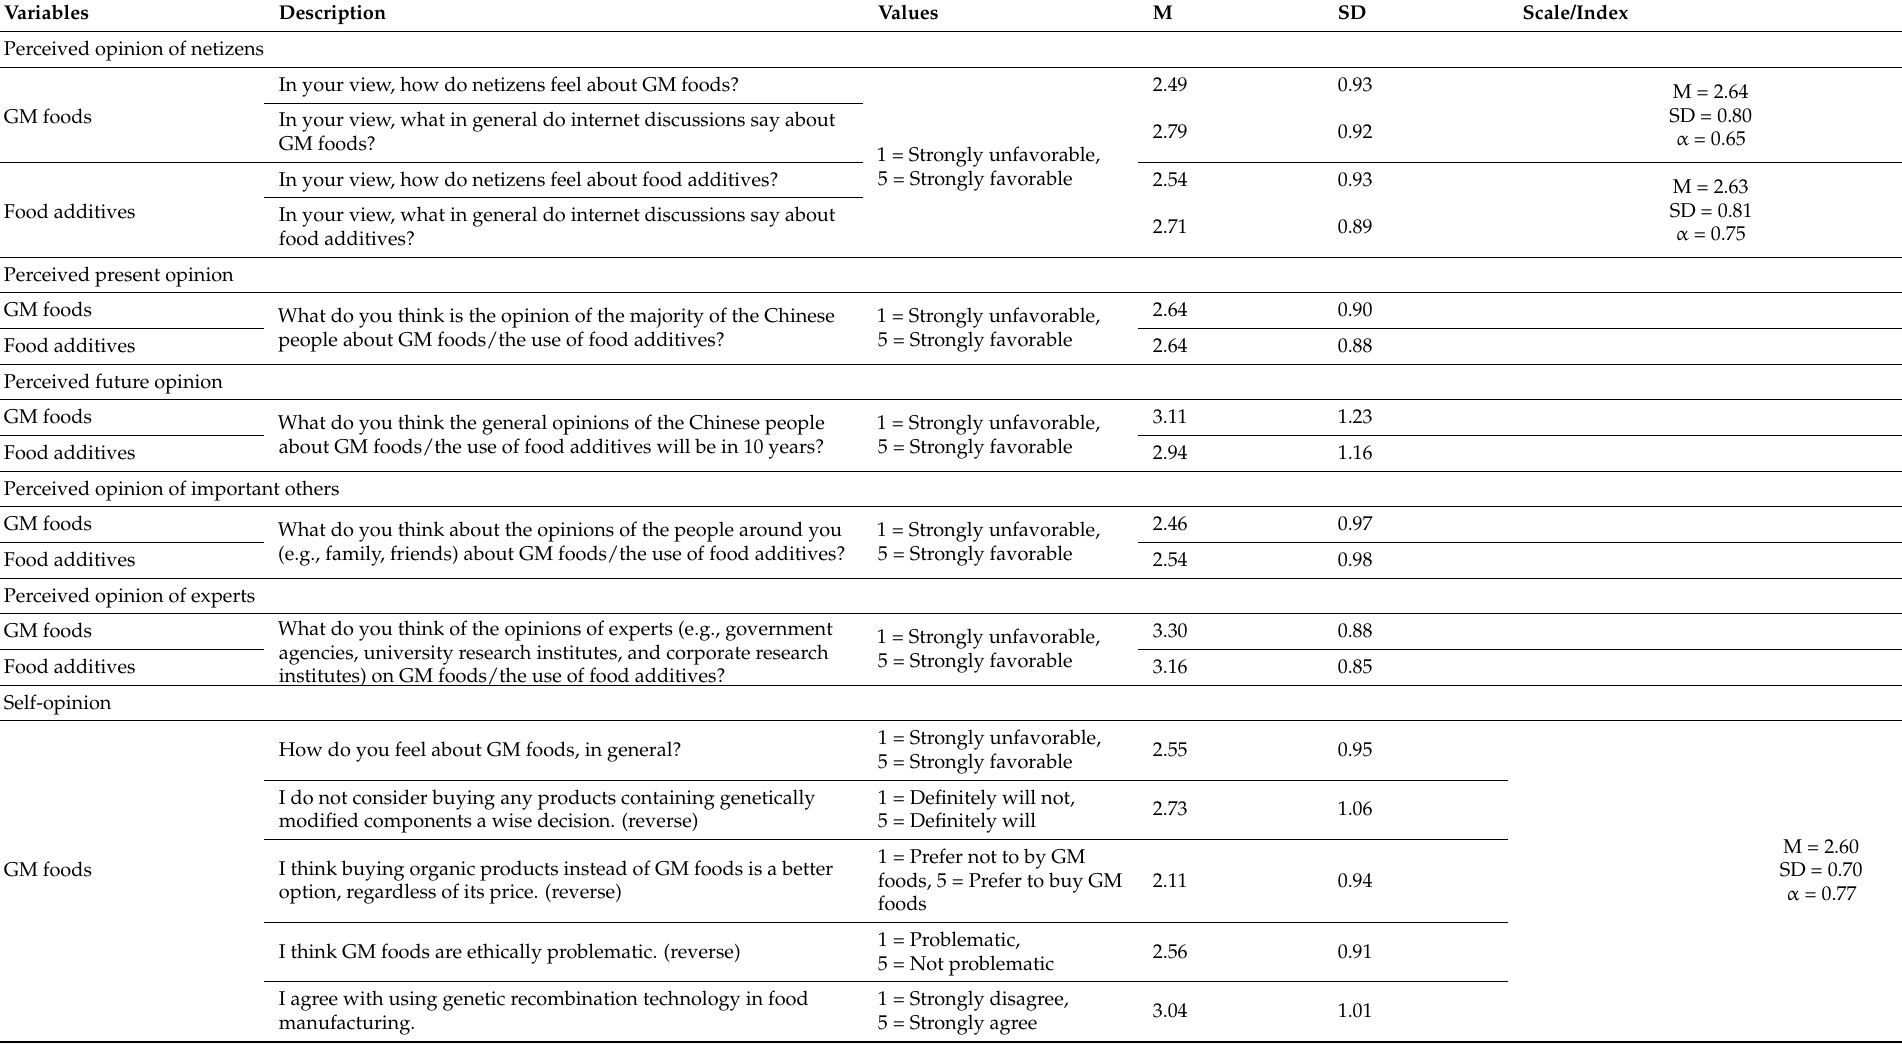
Table 2. Measurement descriptions and statistics of focal